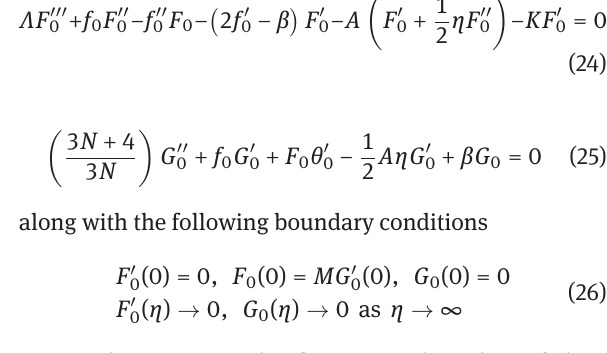
Fig. 2: The Skin friction coefficient f (cid:2)(cid:2) (0) with A for different values of M